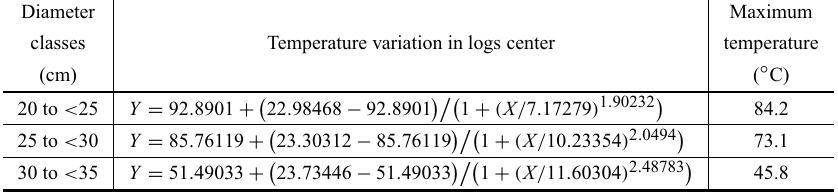
Proposed equations for the temperature behavior in Eucalyptus grandis logs center during steaming. Diameter Maximum classes Temperature variation in logs center temperature